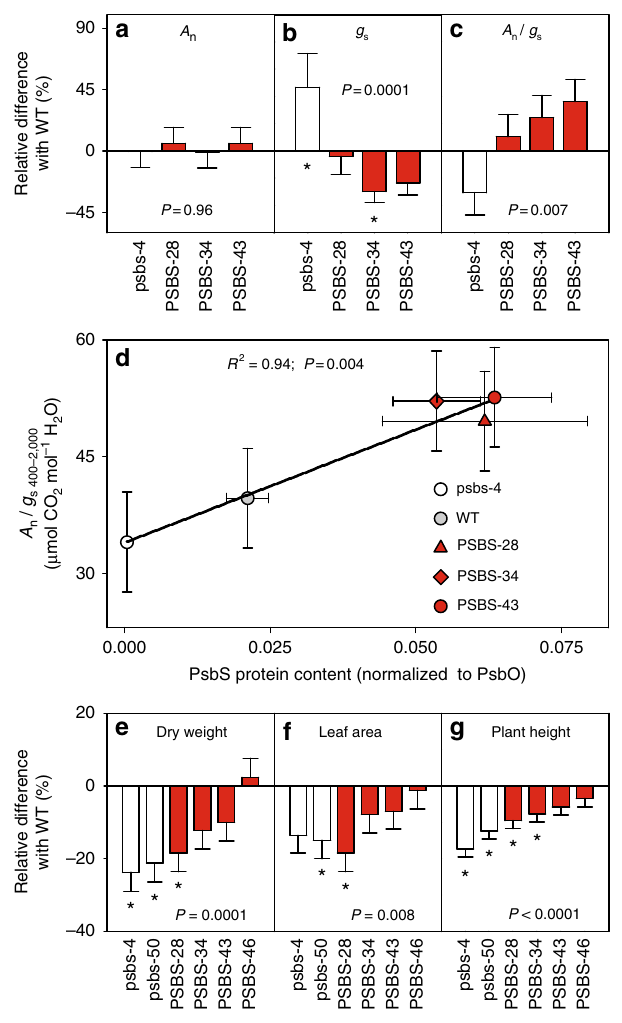
Fig. 3 Photosynthetic water-use ef fi ciency and productivity of fi eld-grown Nicotiana tabacum plants with modi fi ed PsbS levels. a Net CO 2 fi xation rate ( A n ), b stomatal conductance ( g s ), c intrinsic water-use ef fi ciency ( A n / g s ) in tobacco genotypes with modi fi ed PsbS expression levels relative to wild- type tobacco. d Linear correlation between PsbS protein levels and A n / g s at light intensity above 300 μ mol m − 2 s − 1 . e Total dry weight, f Leaf area, and g plant height. Error bars indicate s.e.m. ( a – d N = 4 biological replicates; e – g n = 6 blocks for transgenic and n = 12 blocks for WT), and asterisks indicate signi fi cant differences between transgenic lines and WT (Dunnett ’ s two-way test; α = 0.05), P- values indicate signi fi cance of line effect in ANOVA ( a – c and e – g ) or signi fi cance of regression ( d